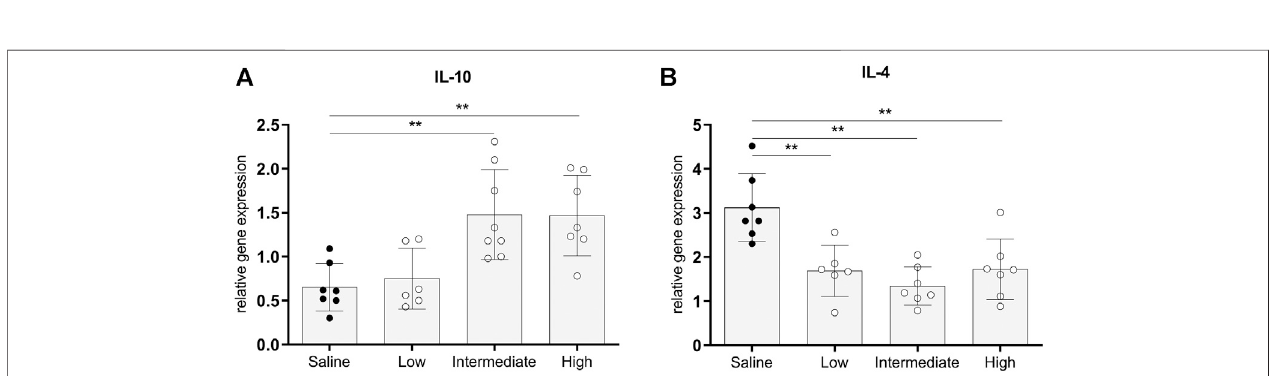
FIGURE5| Anti-in fl ammatorygeneexpressionsinlungtissue.Braindeath(BD)wasinducedinratsassignedtooneoffourexperimentalgroups,etc. and1 hafter BD induction rats were treated intravenously with 1) 0.9% saline (control) 2) low dose methylprednisolone (5 mg/kg of bodyweight (BW), 3) intermediate dose methylprednisolone (12.5 mg/kg of BW) and 4) high dose methylprednisolone (22.5 mg/kg of BW). mRNA gene expression levels of (A) IL-10 and (B) IL-4. Data are shown as expressions relative to housekeeping gene β -actin. Values are presented as mean ± SD. ** p < 0.01.